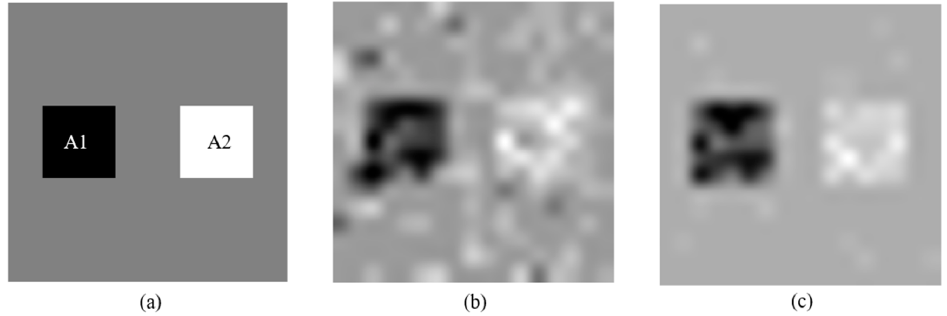
Figure 7. ( a ) Initial sound field model; ( b ) reconstruction results with the sound field threshold set as